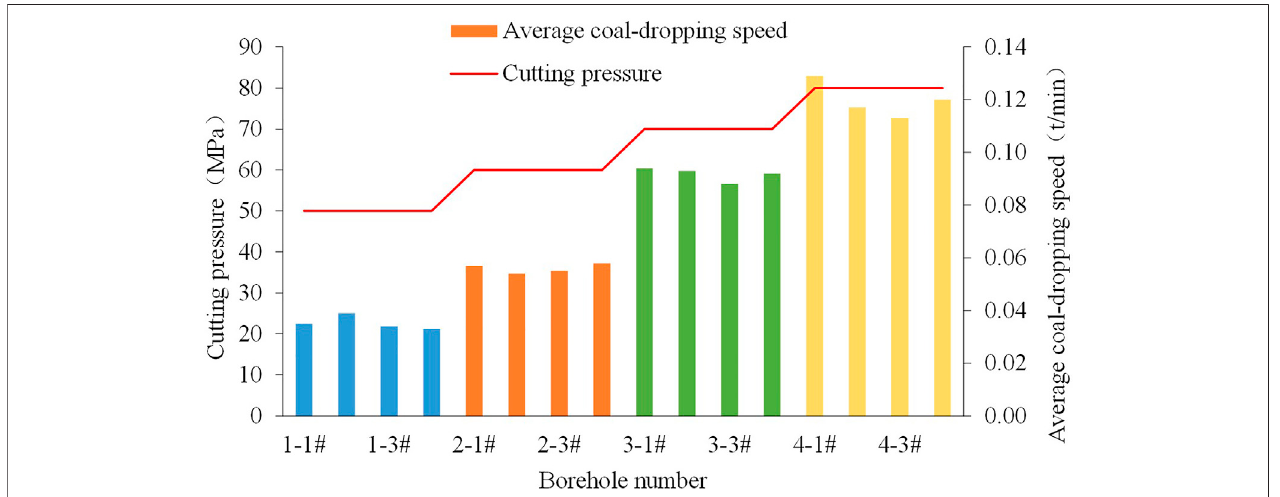
FIGURE 3 | Relationship curve between the cutting pressure and the coal-dropping speed in coal seams with Protodyakonov coef fi cient in the range of 0.3 – 0.5.